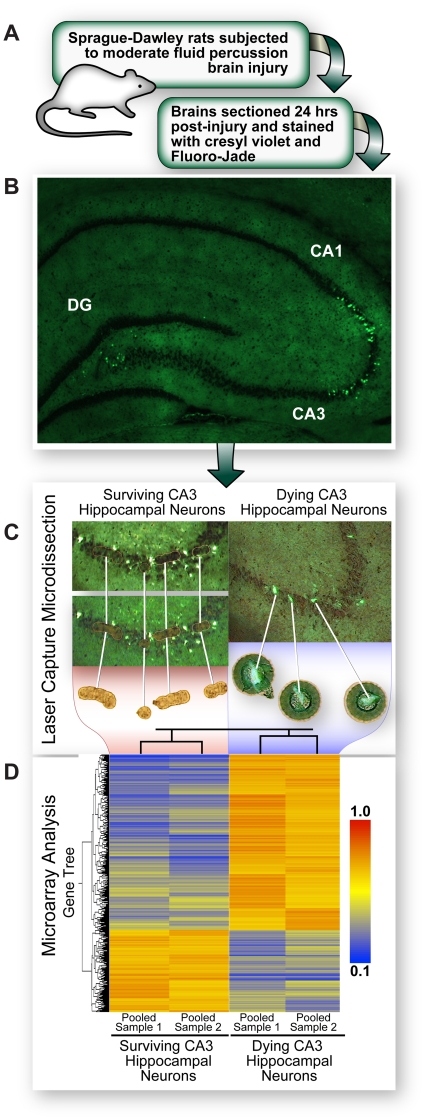
Dying and surviving neurons have distinctive gene expression signatures in rat hippocampus.Moderate TBI results in distinctive patterns of neurodegeneration in selectively vulnerable regions of the rat hippocampus. Dying, Fluoro-Jade-positive and surviving, Fluoro-Jade-negative pyramidal neurons from the CA3 subfield of the rat hippocampus were obtained by laser capture microdissection and subjected to microarray analysis. The gene tree of 2,163 genes differentially expressed greater than two-fold in dying relative to surviving neurons shows that biological replicates of pooled samples are highly concordant. The expression bar, red (1.0) to blue (0.1) indicates increased and decreased expression, respectively, compared with the median intensity of each gene in the array.